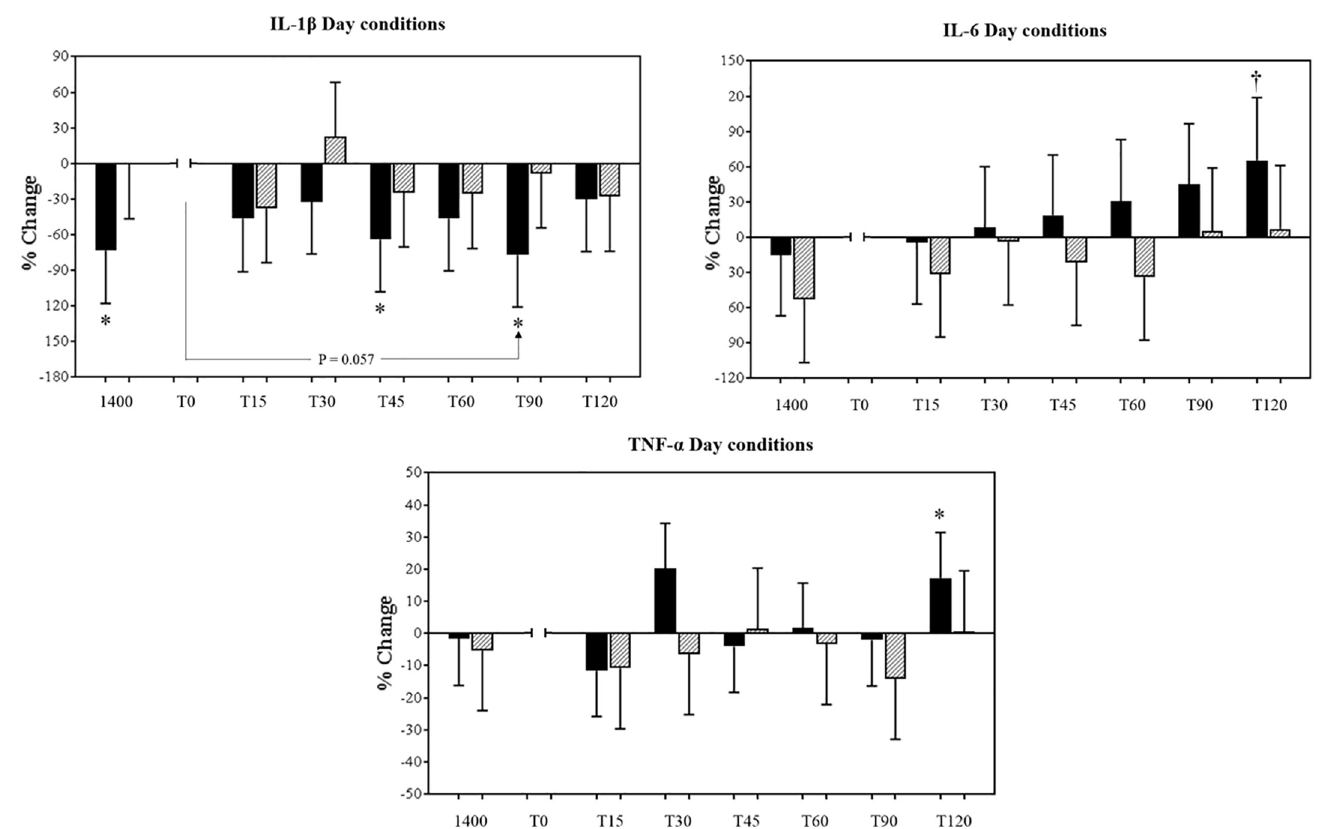
Fig 1. Mean ( ± SEM) percentage changes in Interleuklin-1 beta (IL-1 β ), Interleuklin-6 (IL-6) and tumor necrosis factor alpha (TNF- α ) log-transformed plasma concentrations during 2-h of physiological sampling following a day alarm mobilisation, relative to T0 for each condition, time matched to control conditions. Dark bars (day alarm), light bars (day control). � P < 0.05, † P � 0.001 within-condition change relative to T0, and between-condition changes relative to T0 (denoted by line and P-value).